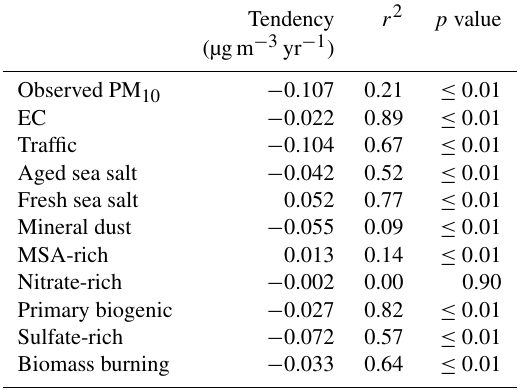
Table 1. STL tendencies of the observed PM 10 and each PMF- resolved source contributions to PM 10 from the year 2012 to 2020 at the OPE